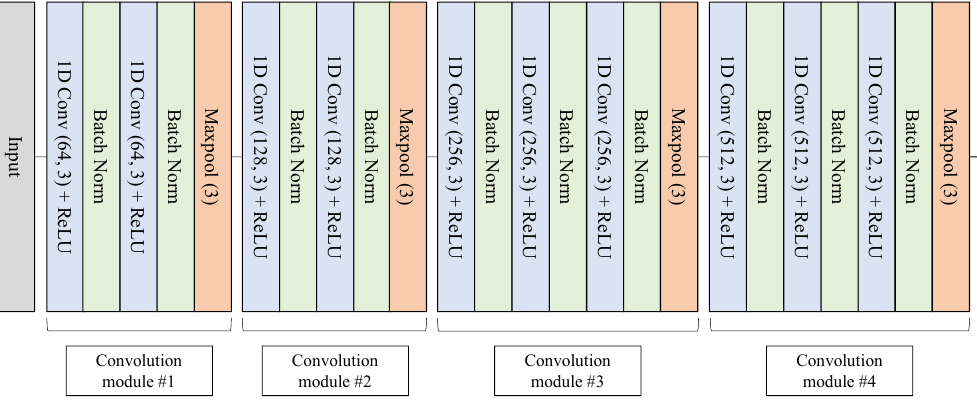
Figure 8. CNN structure of the proposed model.